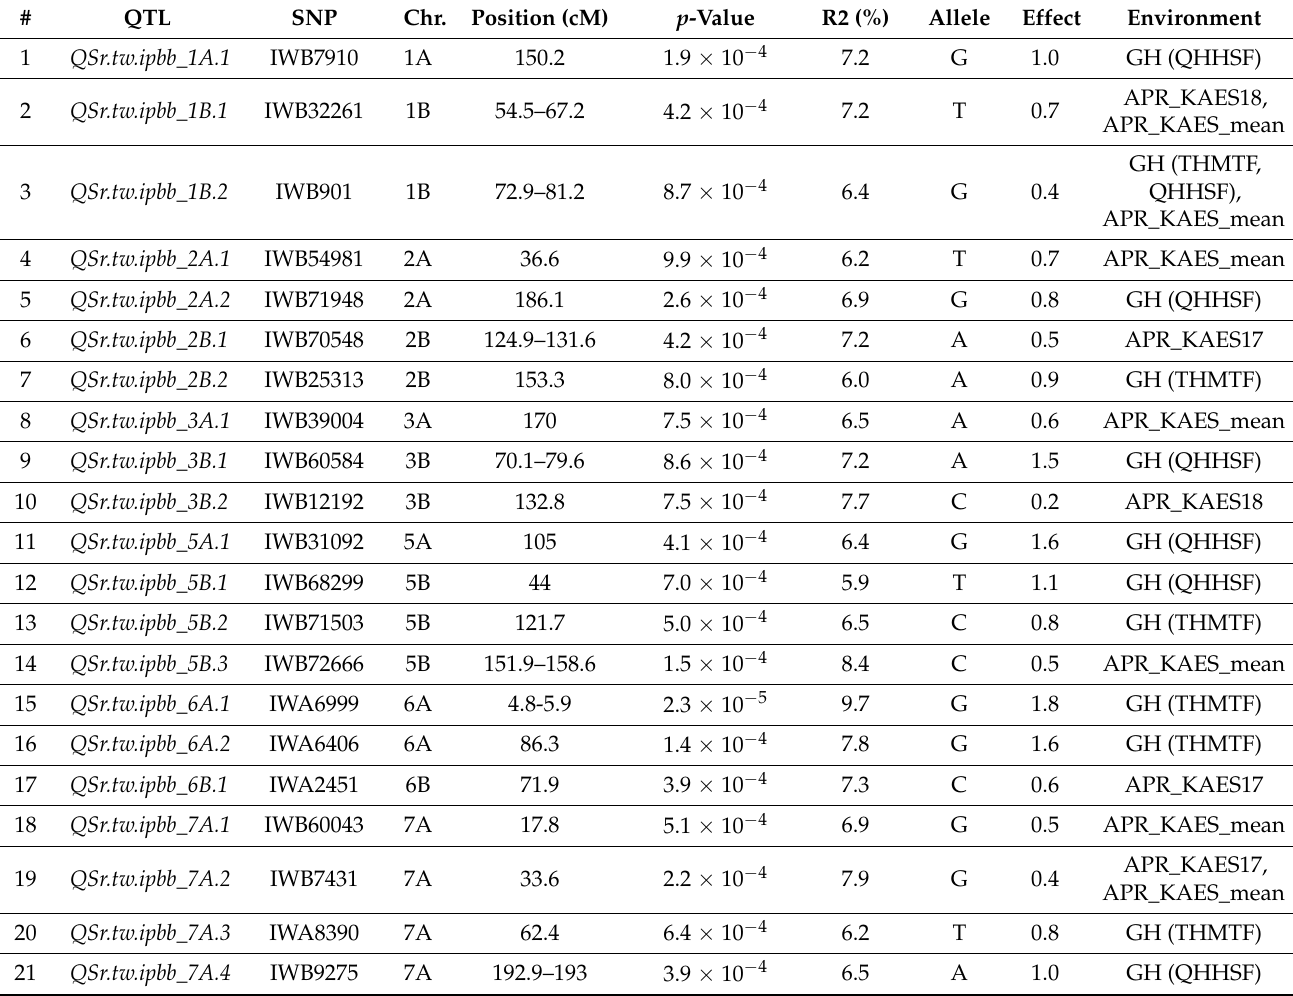
Table 8. QTLs for resistance to stem rust (SR) identified in tetraploid